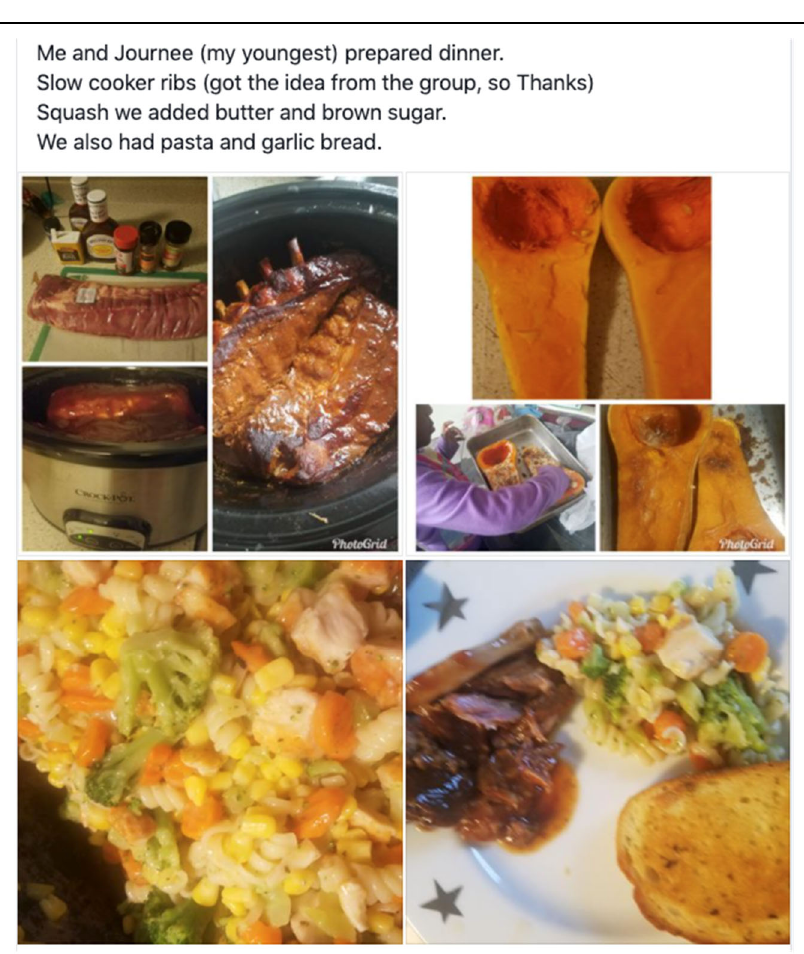
Figure 2. Participant Facebook Post Illustrating the 3P Photovoice Protocol Used by the Madison SFUW-Odyssey Project